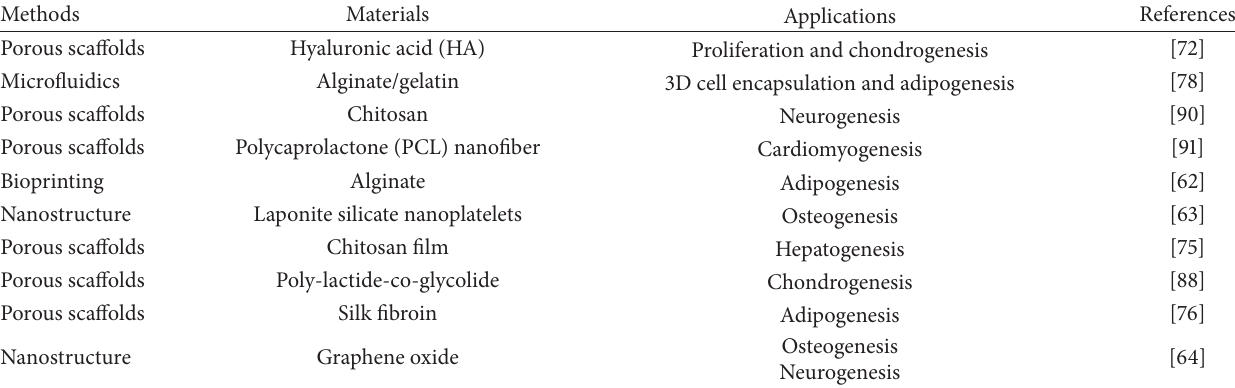
Table 2: Representative biofabrication and tissue engineering methods for ASCs culturing and differentiation.